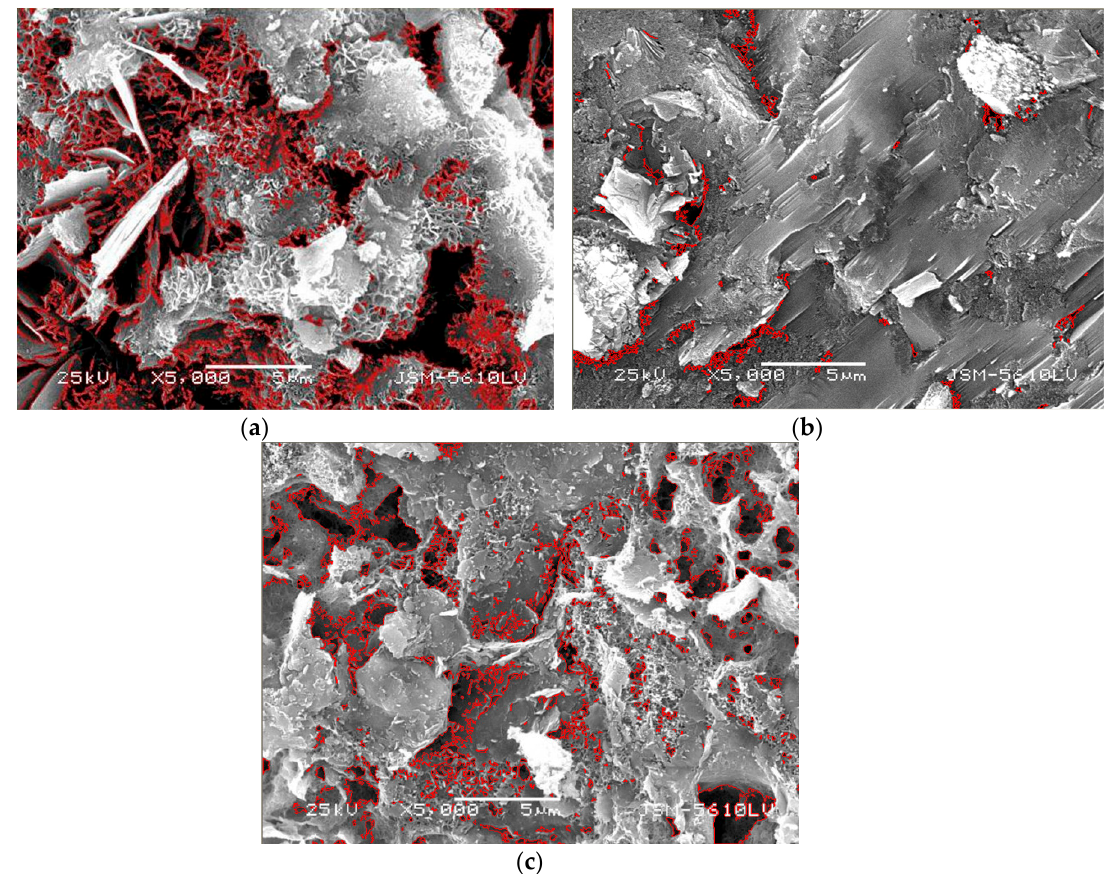
Figure 7. Calculation diagram of the porosity. ( a ): 3-day-PS, ( b ): 28-day-PS, ( c ): 28-day-PC.